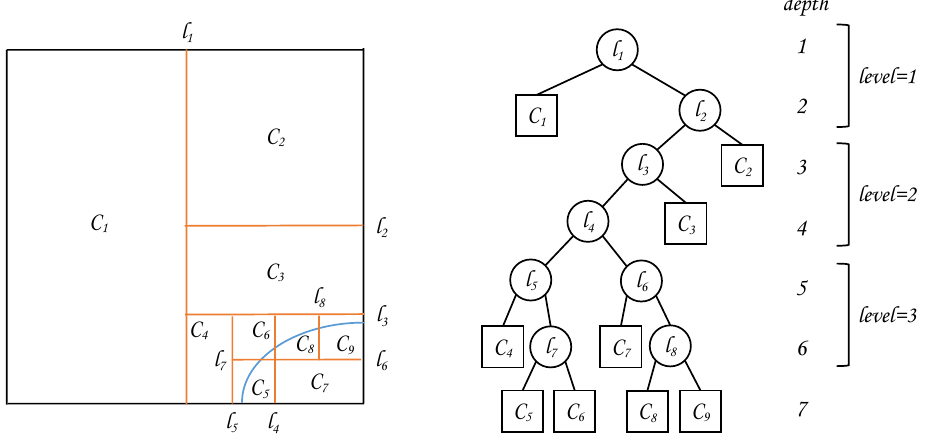
Figure 3. Illustration of kd-tree based sub-division. The maximum level illustrated here is three. Each level consists of two depths that represent different splitting directions; l i (stored in nodes) and C i (stored in leaves) denote a splitting line and a sub-cell,